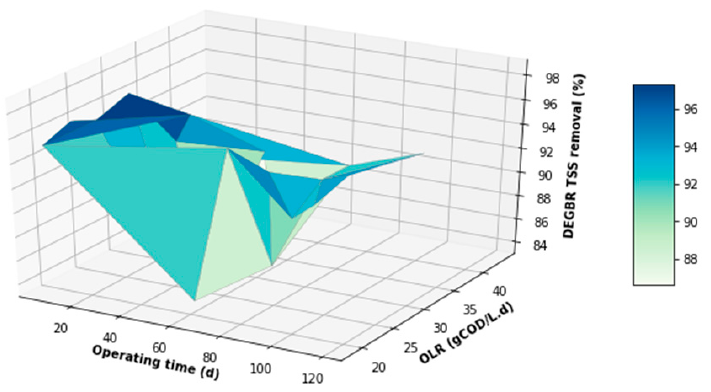
Figure 17. DEGBR TSS removal with respect to the operating time and the OLR.